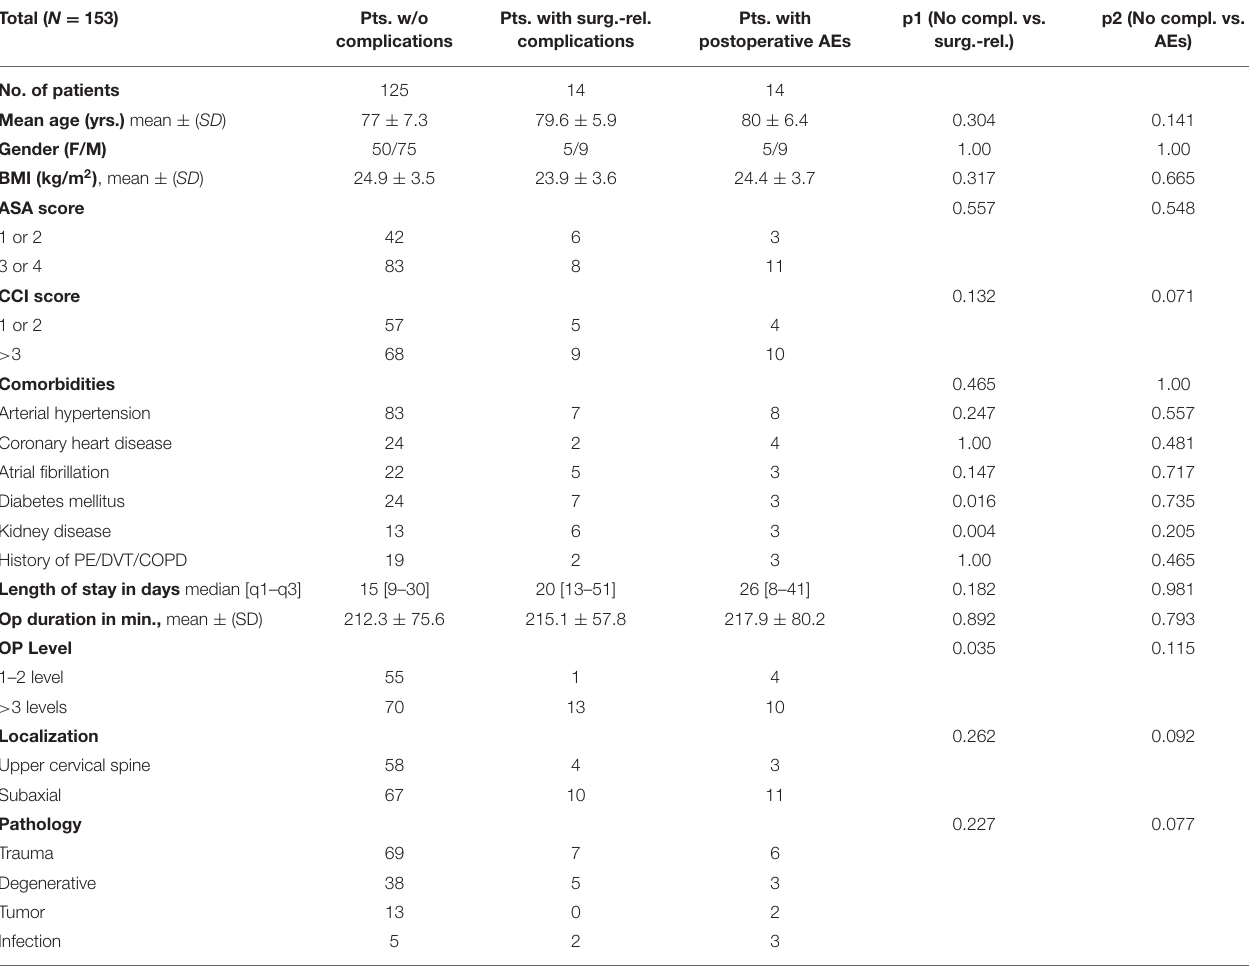
TABLE 2 | Comparison of patients without postoperative complications vs. surgery-related complications and/or adverse events. Total ( N = 153) Pts. w/o